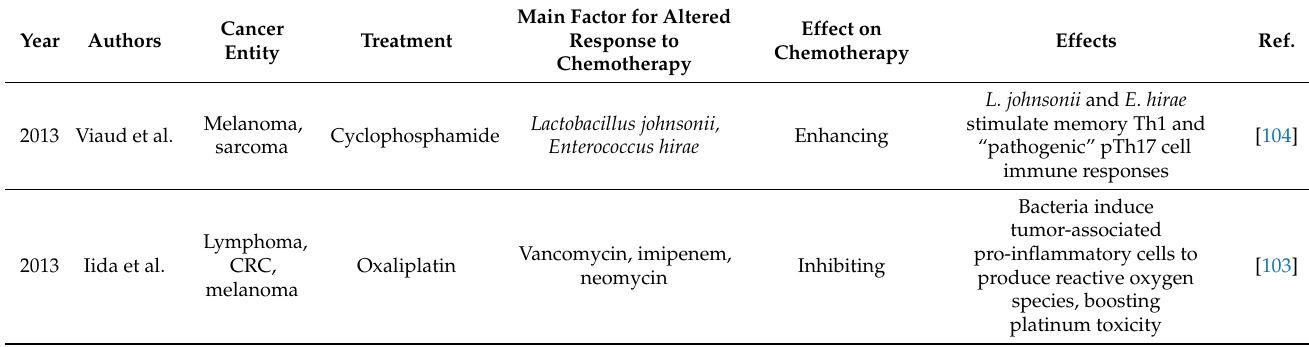
Table 3. Summary of studies on bacteria, bacterial metabolites, or antibiotics influencing the response to